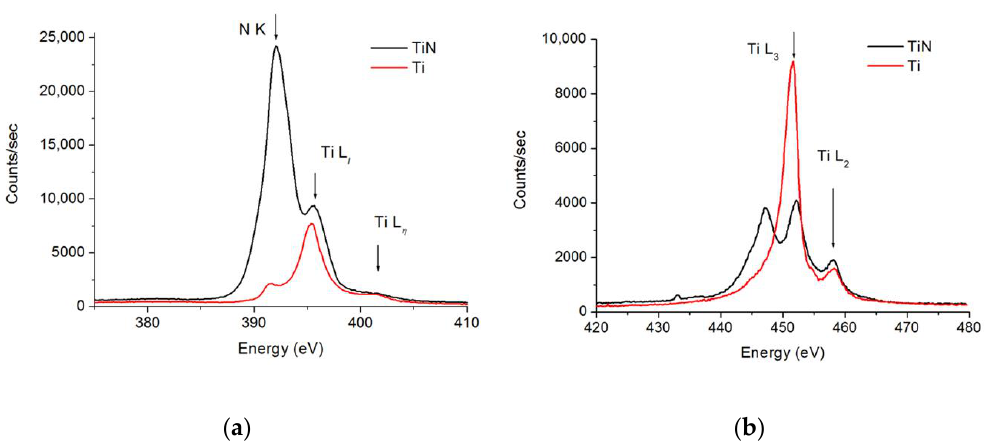
Figure 8. ( a ) Measured L 2 and L 3 spectra of Ti and TiN. ( b ) Measured L η , L l , and N K α spectra of Ti and